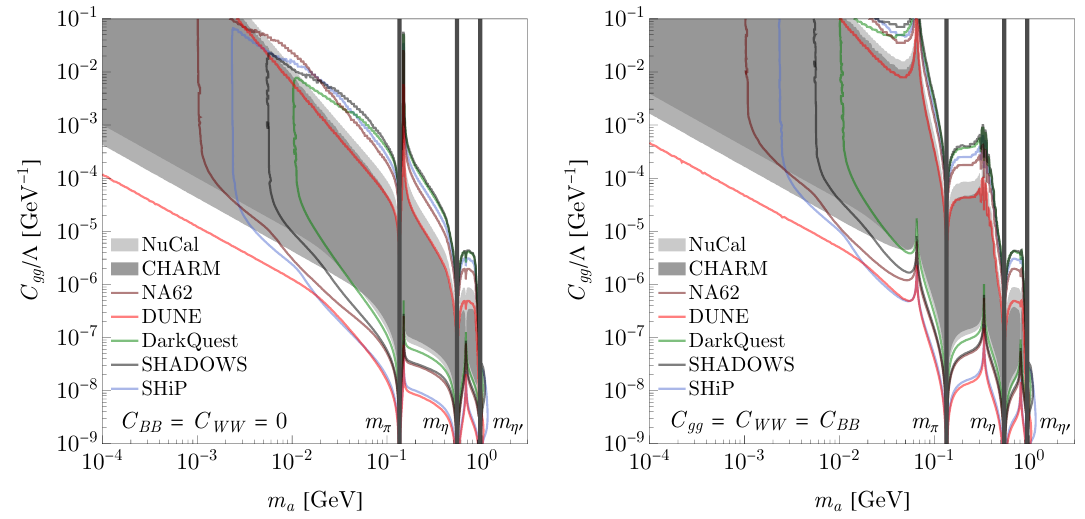
Figure 6 . 90% CL exclusions limits for scenarios (iii) (left) and (iv) (right) assuming a di-gamma search